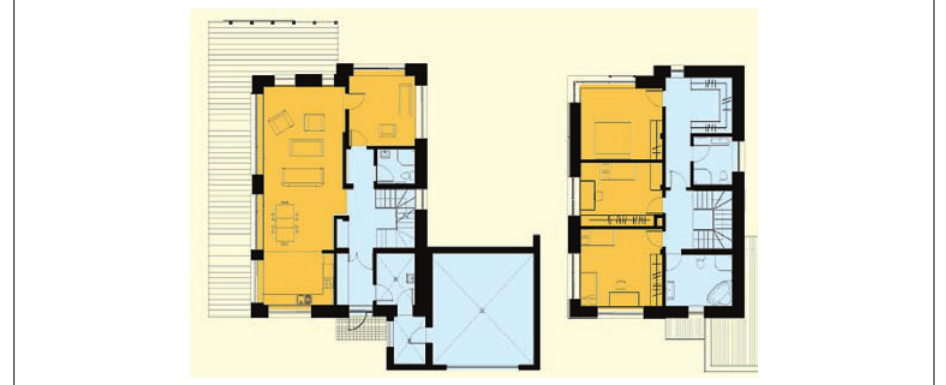
Fig. 2. The planning solution of the passive